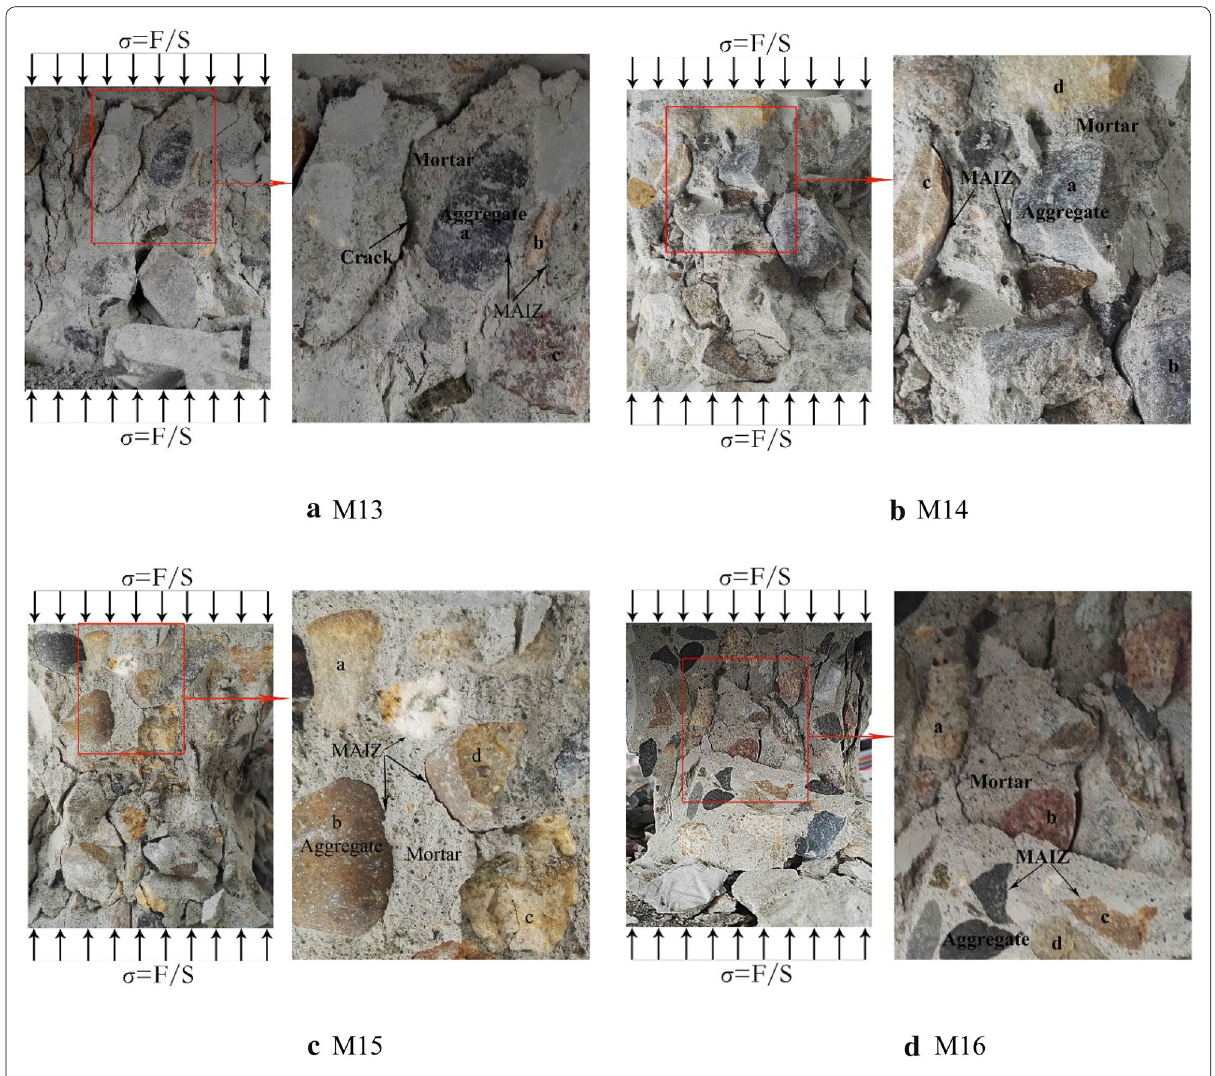
Fig. 6 The failure of type of FAGC samples at 480